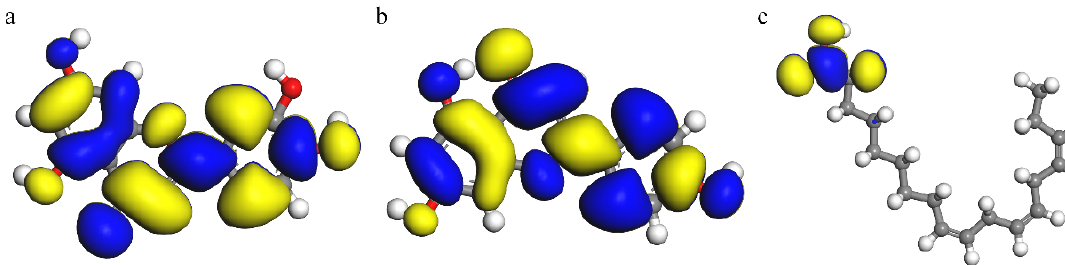
Figure 11. LUMO: ( a ) luteolin, ( b ) apigenin and ( c ) α -linolenic acid.